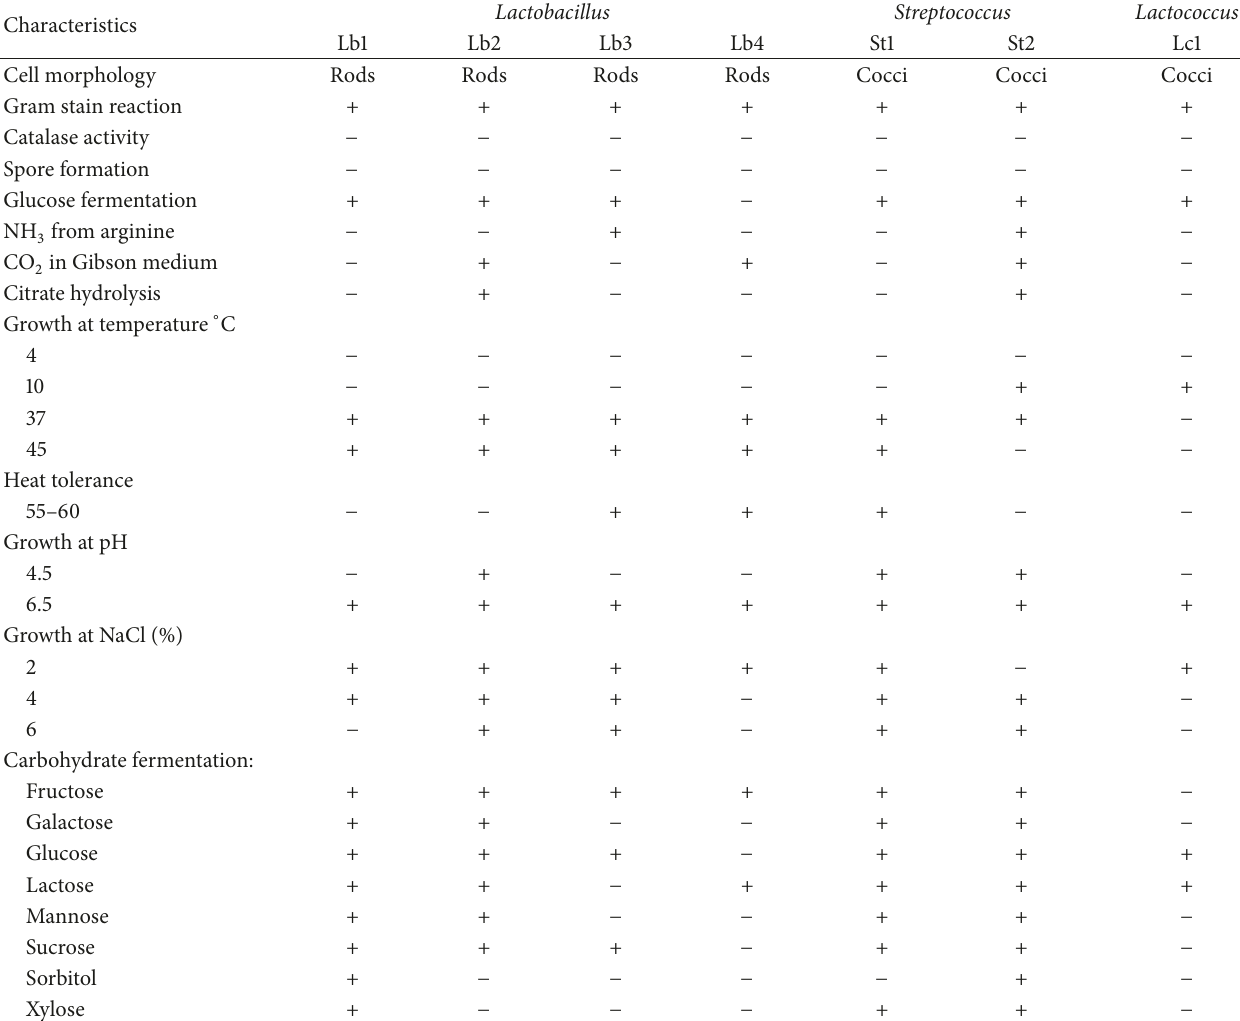
Table 1: Physiological and biochemical characteristics of the LAB isolates from ergo